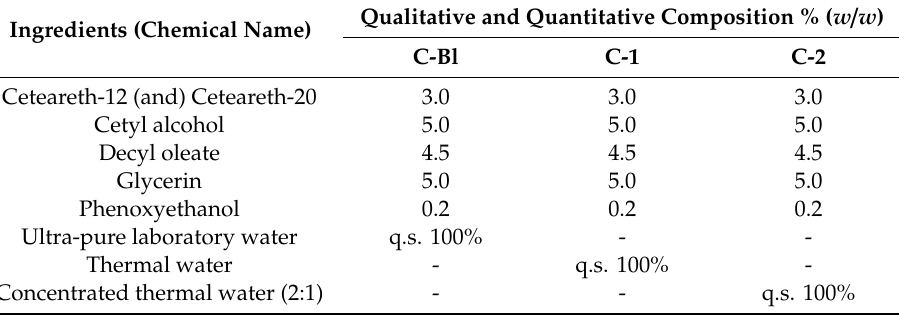
Table 1. Composition of the three creams